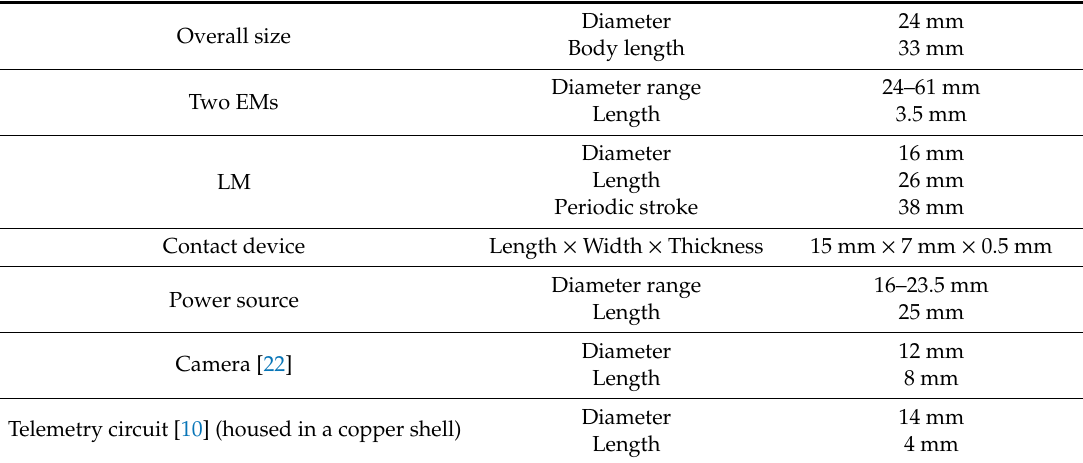
Table 2. Geometric parameters of the enhanced